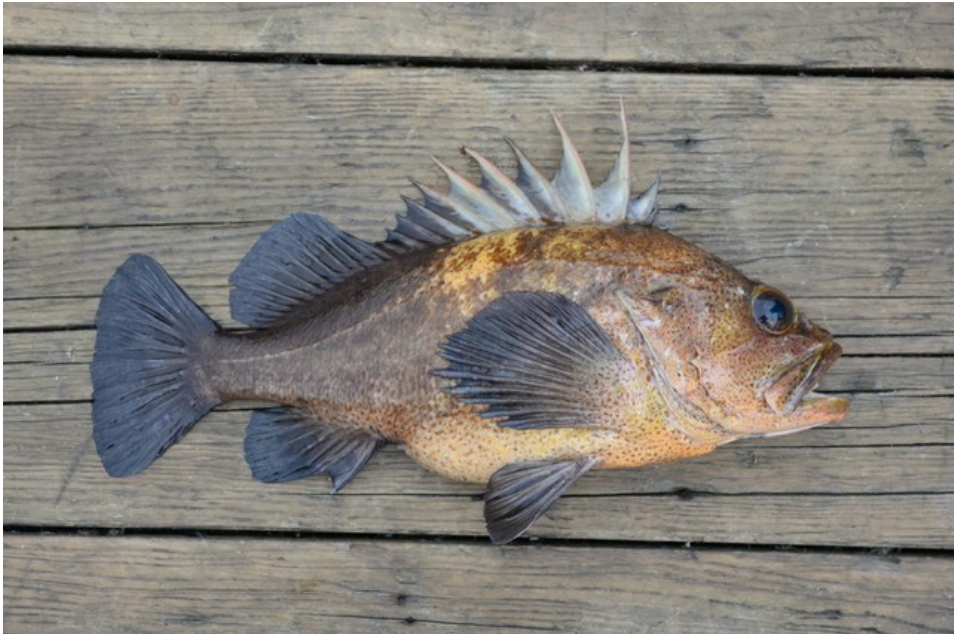
Figure 1. Photograph of adult male Sebastes maliger captured in Frederick Sound, Alaska in June 2016 (photograph by Riley Nelson).